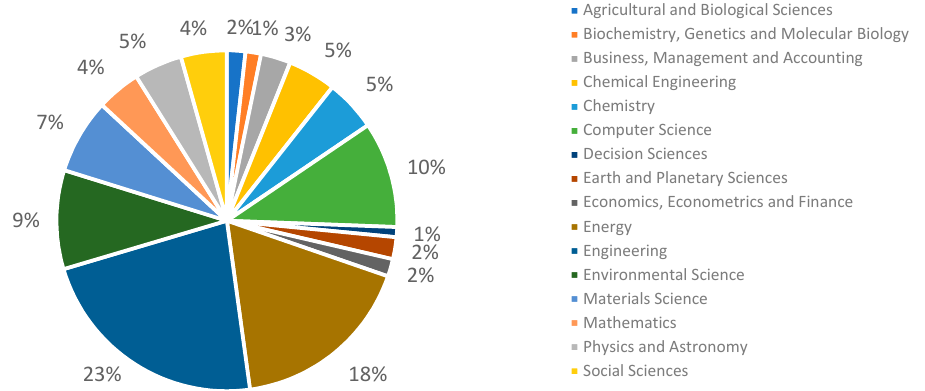
Figure 4. The main subject areas studying green electricity production technology (source: developed by the author based on Scopus and VOSviewer).